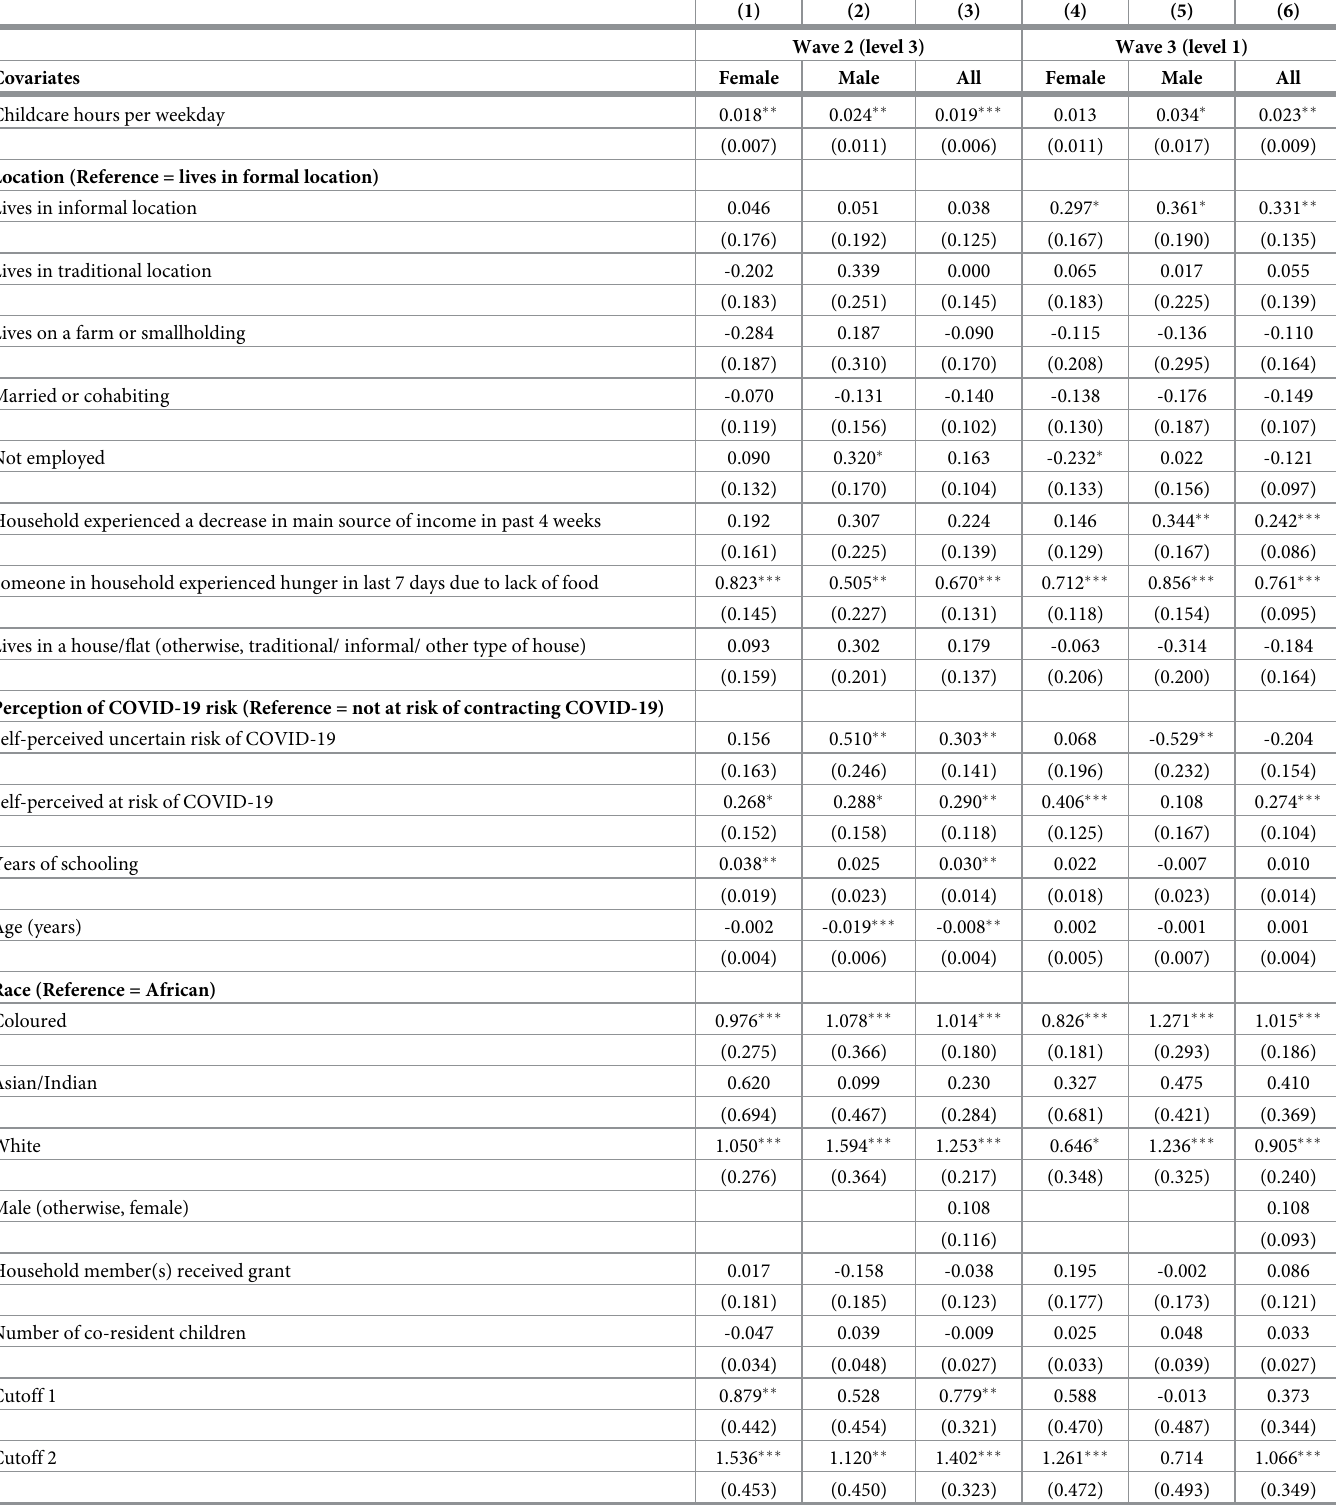
Table 2. Relationship between depression and